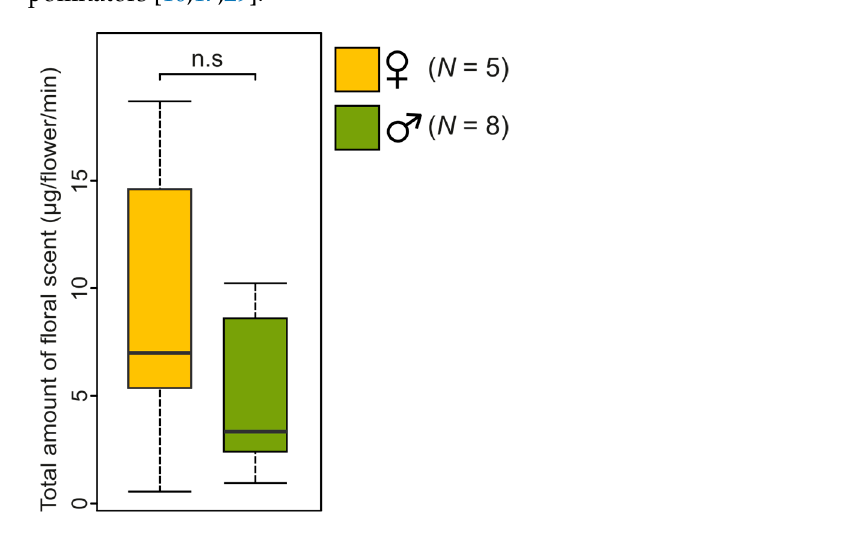
Figure 2. Comparison of the total amount of floral scent emitted by male and female single flowers of C. maranhense (Median, 25%–75%, confidence interval of 95%). n.s. indicates no significant difference at p > 0.05 (PERMANOVA).